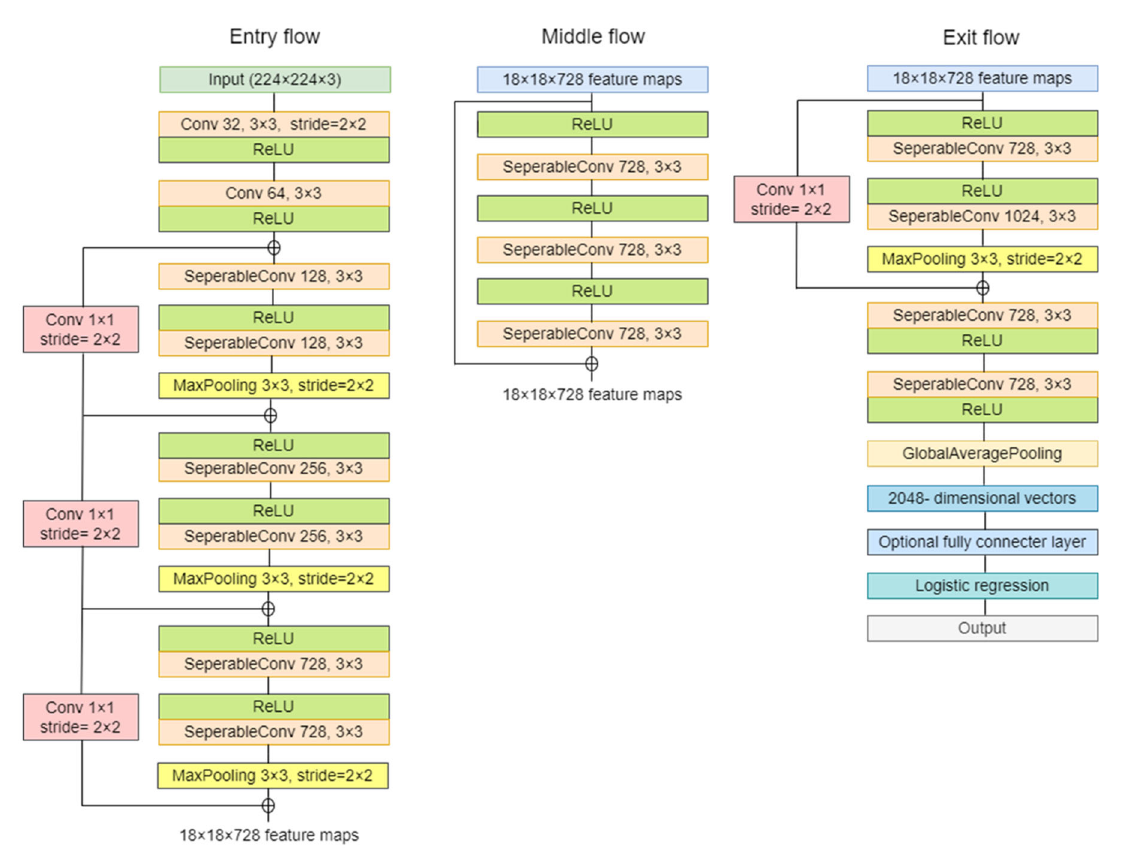
Figure 7. Xception architecture.